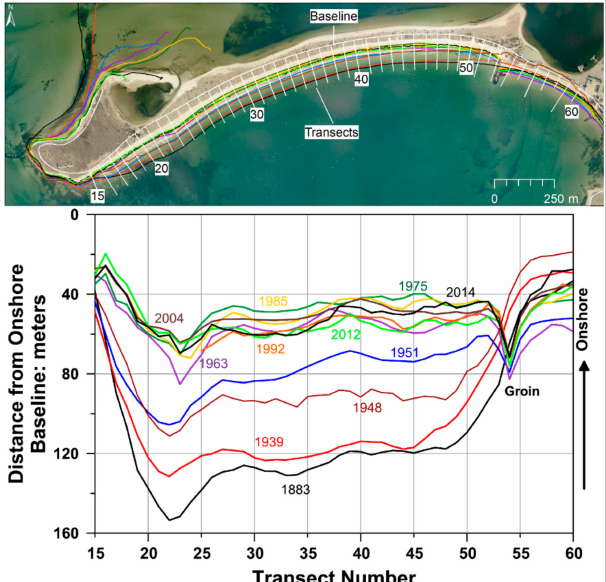
Figure 6. ( Top ) Digital orthophotograph of the Napatree Barrier showing the location of the transects used in this study. ( Bottom ) Distance from the onshore baseline for transects 15–60 for Napatree Point. The barrier begins at transect 20. Note the migration of the shoreline between 1939 and 1975, and the lack of change in position between 1975 and 2014. The apparent progradation of the shoreline at transect 54 represents the installation of the small groin between 1948 and 1951. The impact of the groin on shoreline position appears to be limited to transects 51 to 56.